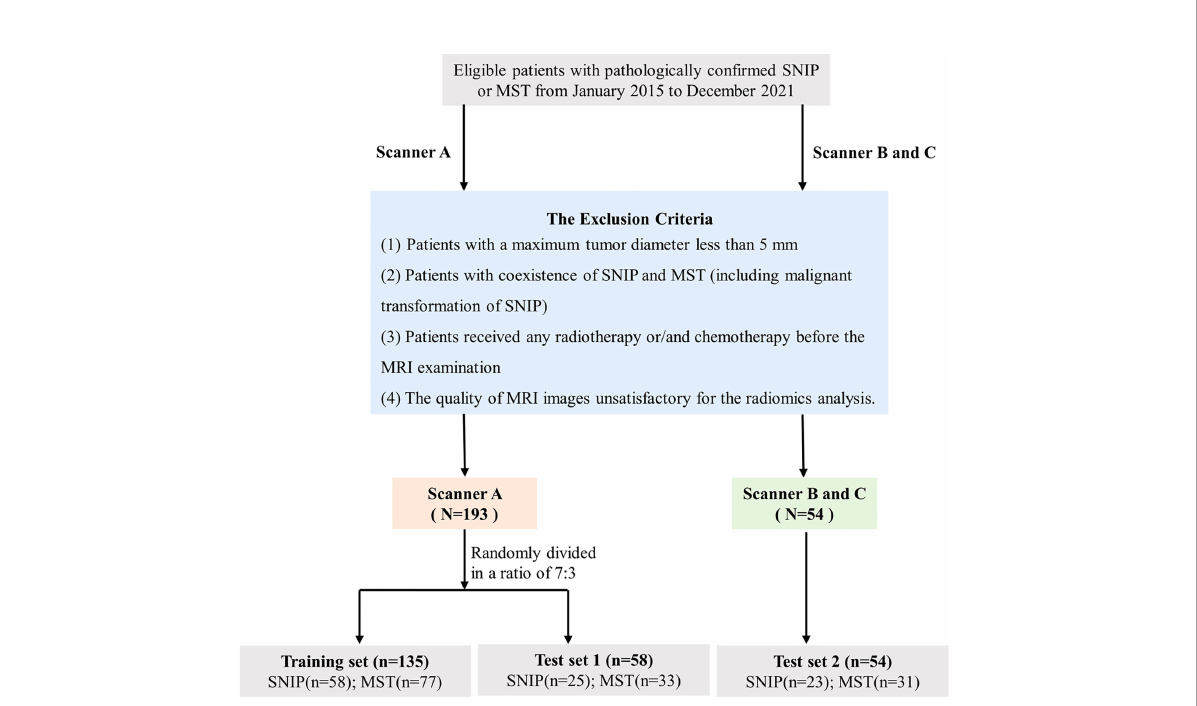
FIGURE 2 Flowchartof the study population selection. SNIP, sinonasal inverted papilloma; MST, malignant sinonasal tumor;MRI, magnetic